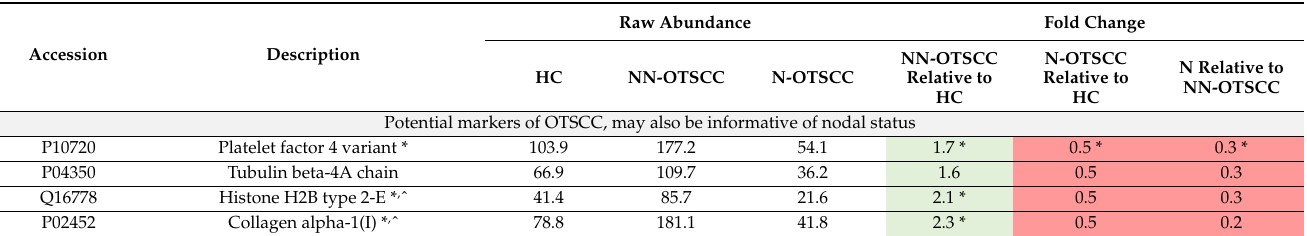
Figure 2. Cellular and biological pathways that are over-represented among extracellular vesicle associated proteins. ( A ) EV data were compared with Vesiclepedia to verify that most proteins identified have been previously reported as EV-associated. ( B ) EVs/exosomes were the most enriched cellular components. The x axis on the left represents the percentage of proteins (blue bars) identified in our data set that are expressed or involved in each category. The x axis on the right represents the significance of this as log 10 ( p -value) (yellow line). The red line represents the significance at p = 0.05 as a reference. ( C ) The complement cascade and integrin signaling were the most overrepresented biological pathways. Table 2. Top most deregulated candidate EV-associated proteins between healthy controls and oral tongue cancer. Proteins that increase or decrease in expression by 1.5 fold or greater are shaded in green or red respectively. Healthy controls (HC), non-nodal oral tongue squamous cell carcinoma (NN-OTSCC), nodal oral tongue squamous cell carcinoma (N-OTSCC). * Marks fold change that was similar to that observed in head and neck cancer tissues based on TCGA RNA-sequencing data. ˆ Marks proteins that were also expressed in head and neck tumor